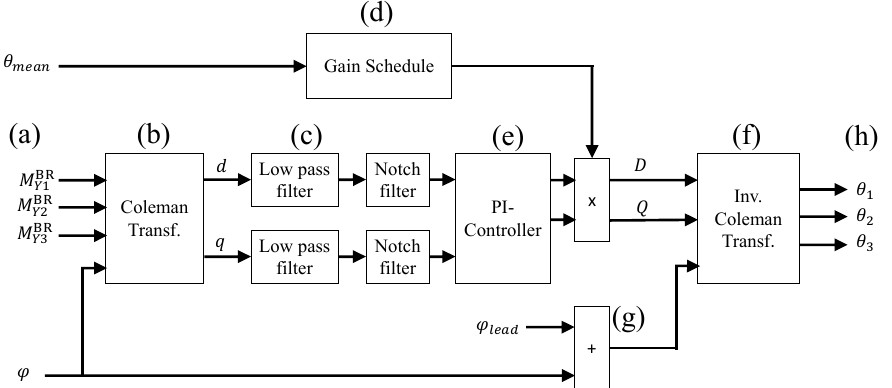
Figure 4. Graphical representation of the Individual Pitch Control (IPC) strategy implemented in the controller. The Blade Root Bending Moments (BRBM) signals are transformed into a non-rotating coordinate system and filtered using a low-pass and a notch filter. The filtered signals are then used in a PI controller to calculate the control signals. These signals are transformed back into the rotating frame of reference to be used as input for the individual pitch